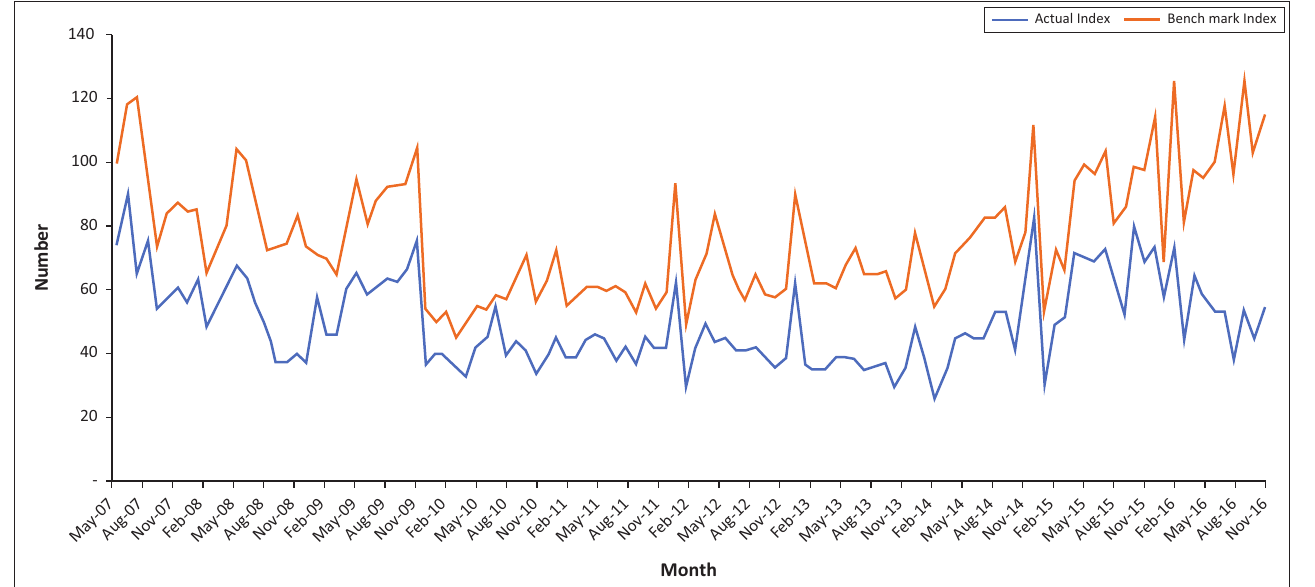
FIGURE 8: Consolidated benchmark index compared to consolidated actual